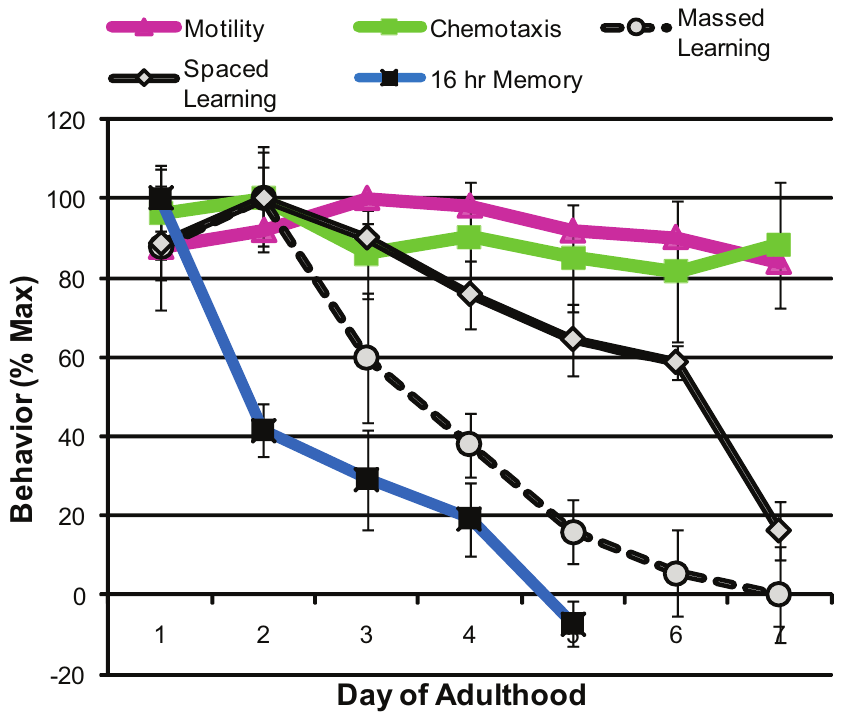
Figure 4. Learning and memory behaviors display the earliest age-related decline. During the first week of adulthood, motility and chemotaxis ability are maintained, while 1 6 massed and 7 6 spaced learning and long-term associative memory abilities are lost by Day 7 and Day 5 of adulthood, respectively. n =6 trials (except Mobility, n =1 trial); 6 SEM.